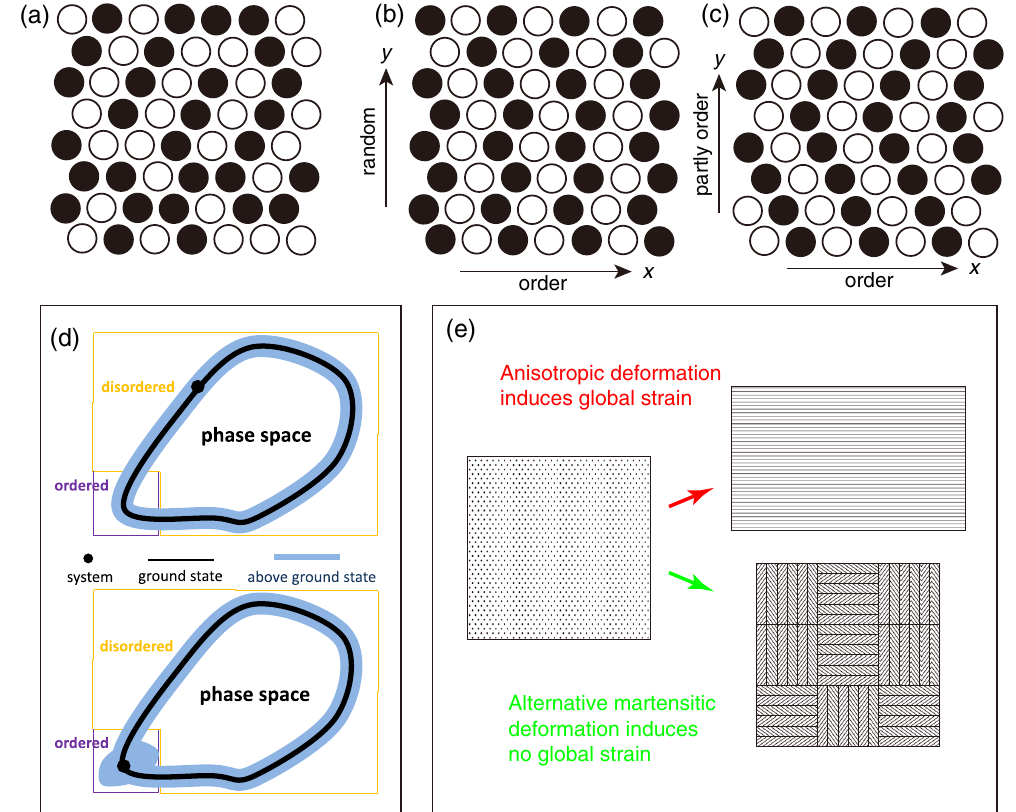
FIG. 10. (a) – (c) Examples of the ground states of AFIT. Panels (b) and (c) are ground states of deformable AFIT, but (a) is not. (a) Among e 0 . 323 N ground states, a typical one has disorder structures composed of motifs 0, 1, 2b, 2c, and 3c. (b) Random zigzag stripe patterns can be viewed as ordered 1D arrays with alternative Ising states along the x direction stacking randomly in the y direction; hence, there are 2 ways of stacking, i.e., 2 text. To jump to another ground state of the deformation AFIT model, one row of spin ( corresponds to a high-energy barrier and results in glassiness. Similarly, in buckled crystals, when the effective temperature is lowered towards the ground state, there are less free spins (motif 3c) and, consequently, jumping from one low-temperature state to the other requires more spins to collectively flip; thus, it is more glassy. (c) More ordered zigzag stripes with longer persistence lengths due to the order-by- disorder effect illustrated in (d). (d) The order-by-disorder effect illustrated in phase space. We replot Fig. 3 of Ref. [5]. Ordered real-space structures correspond to the bottom left region in the phase space. In the top panel without the order-by-disorder effect, the system tends to be in a disordered state because the vast majority of ground states are disordered. The bottom panel depicts a phase space with the order-by- disorder effect: the system tends to be in an ordered state because thermal fluctuation can explore more phase space in the ordered